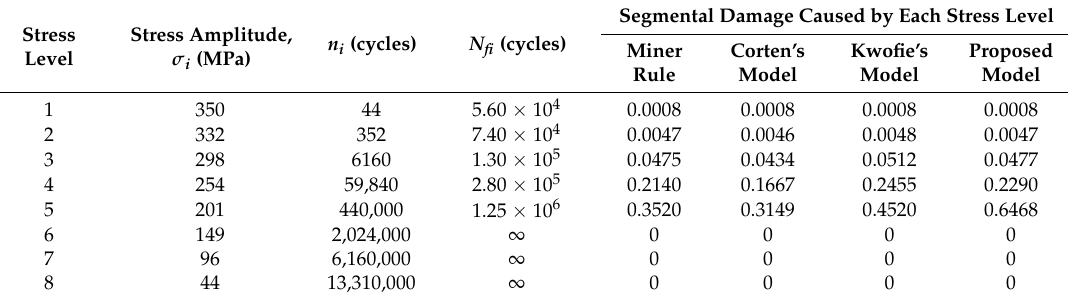
Table 7. Experimental data and the predicted damage for CFD2 test.